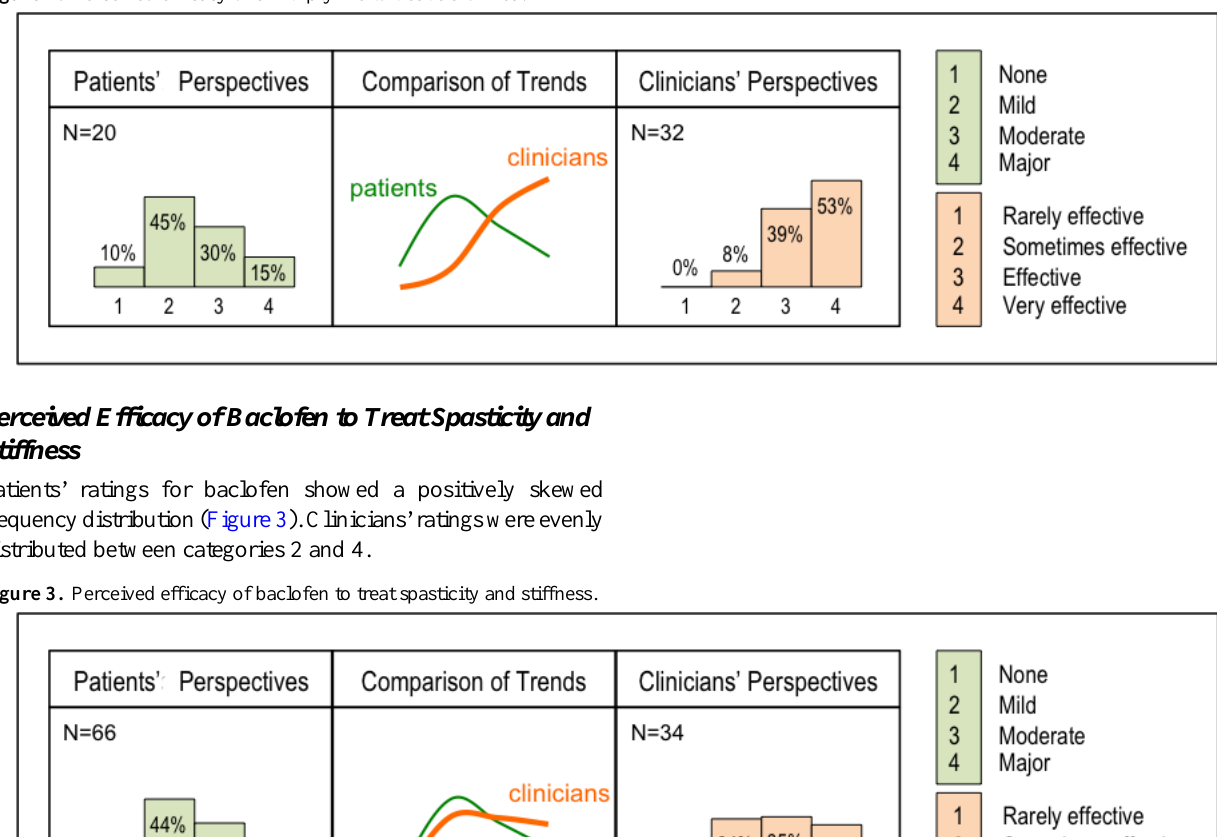
Figure 2. Perceived efficacy of amitriptyline to treat sialorrhea.